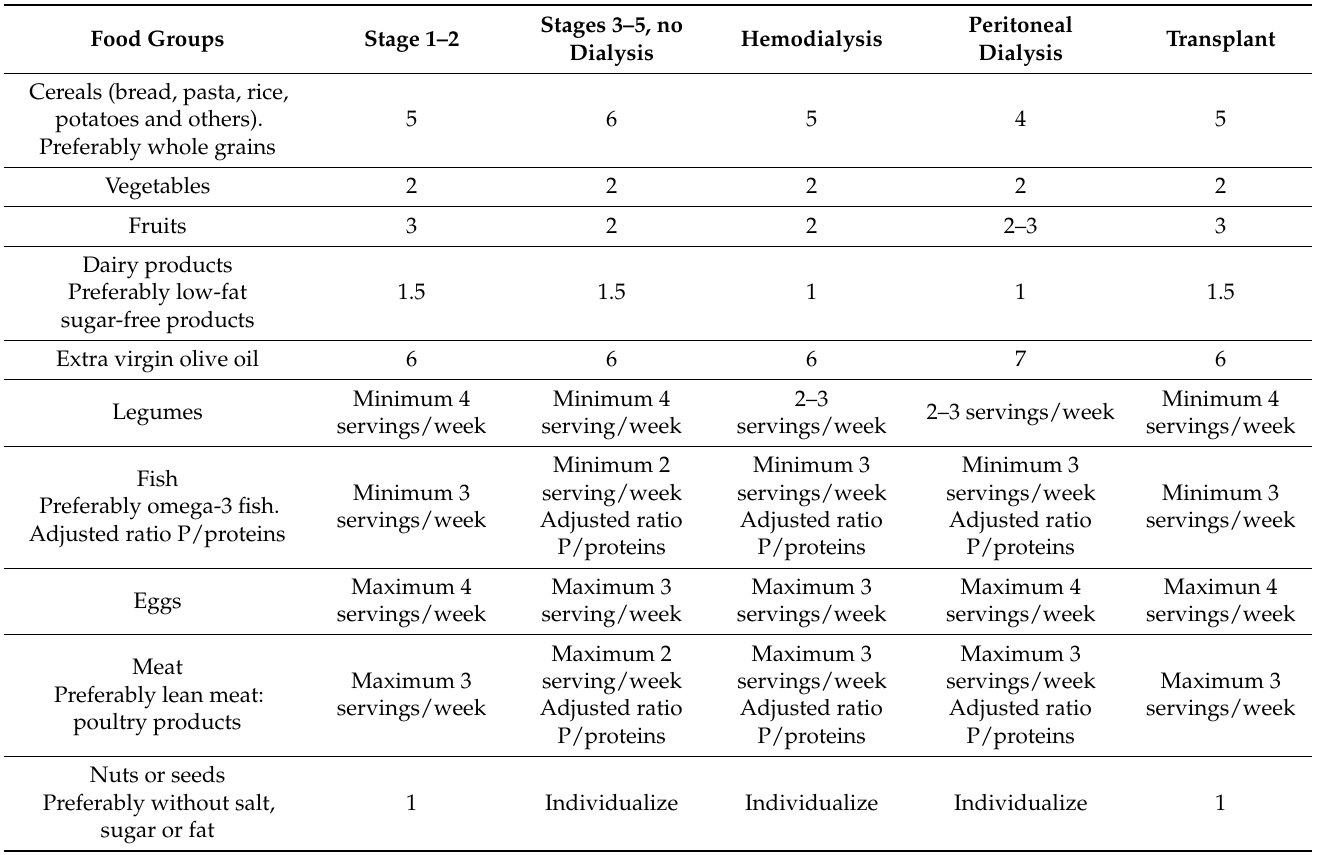
Table 3. Frequency recommendation foods adapted to Mediterranean diet (MD) and chronic